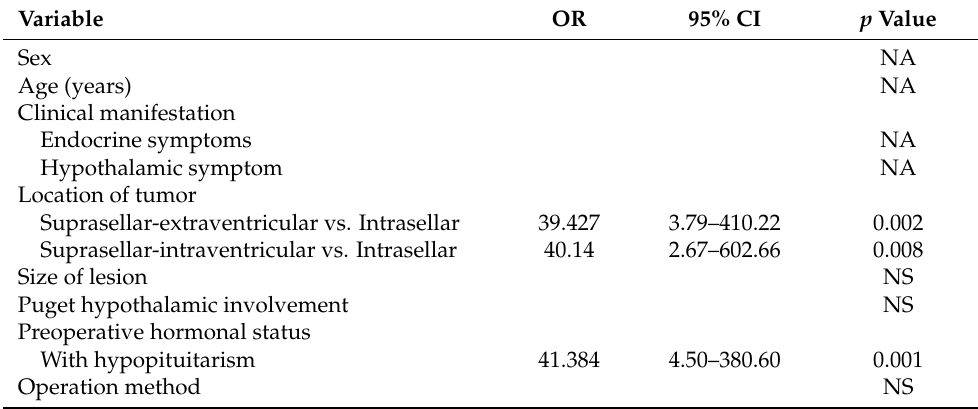
Table 5. Logistic regression analysis of factors related to postoperative hypopituitarism in cranio- pharyngioma